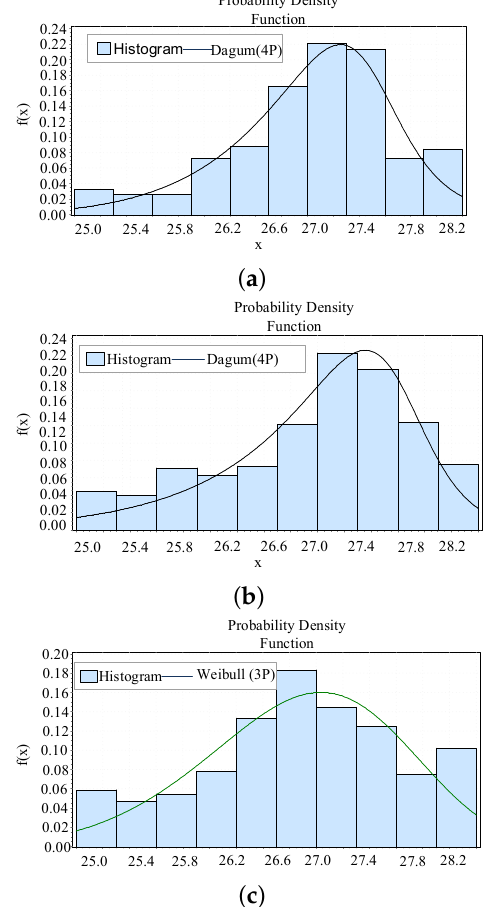
Figure 9. Distribution of the setpoint temperature in Scheme A, Scheme B, and Scheme C when N = 800. ( a ) Distribution of the setpoint temperature in Scheme A when N = 800. ( b ) Distribution of the setpoint temperature in Scheme B when N = 800. ( c ) Distribution of the setpoint temperature in Scheme C when N =